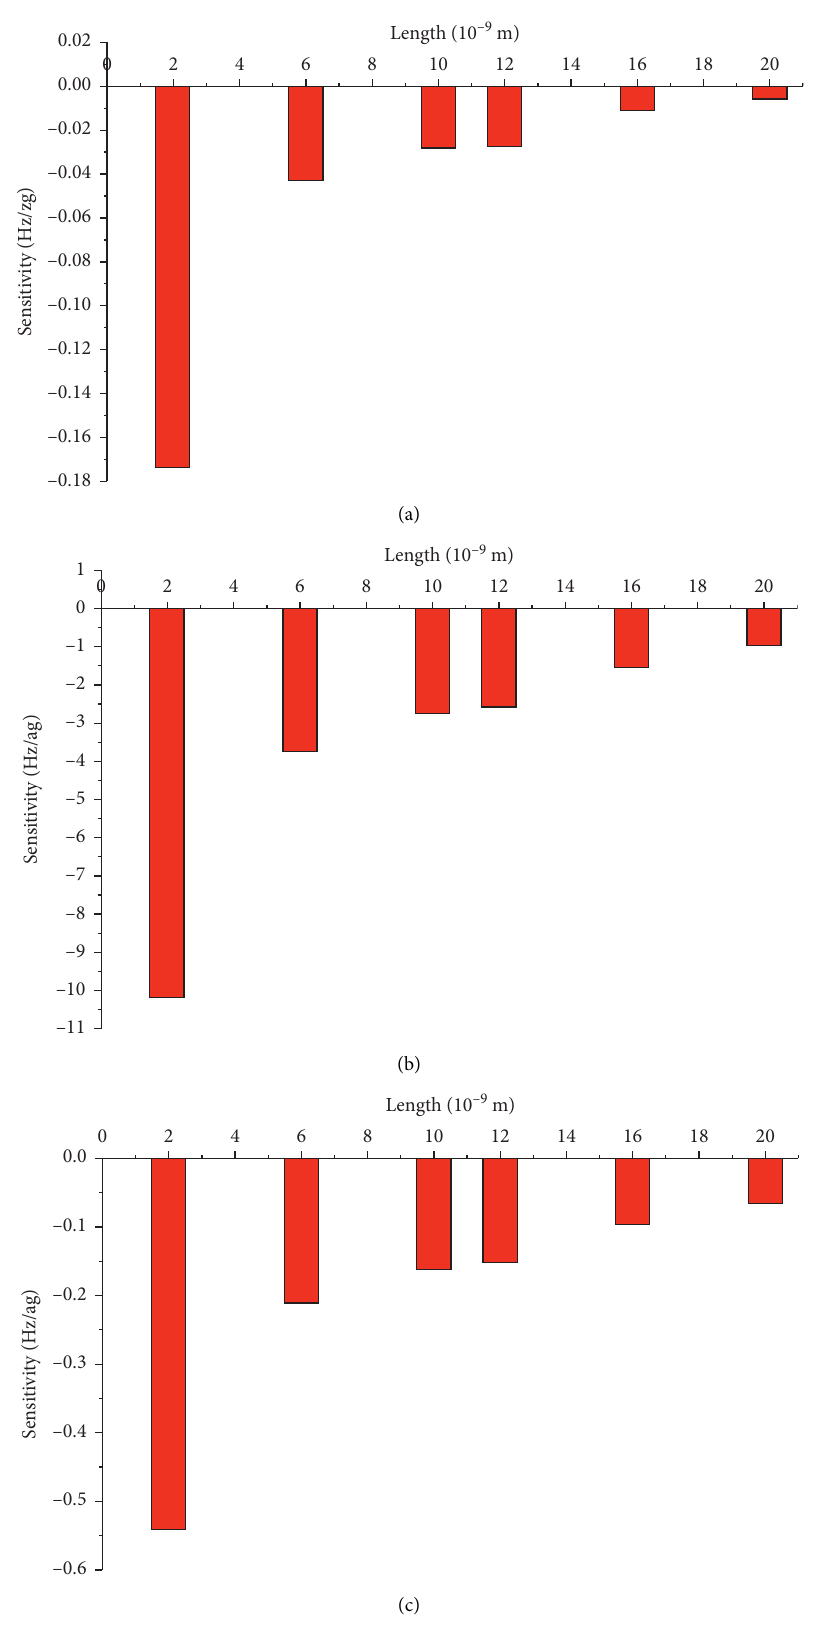
Figure 13: Fixed-fixed boundary sensitivity analysis for (a) insulin, (b) IgG, and (c) LDL biological objects mass